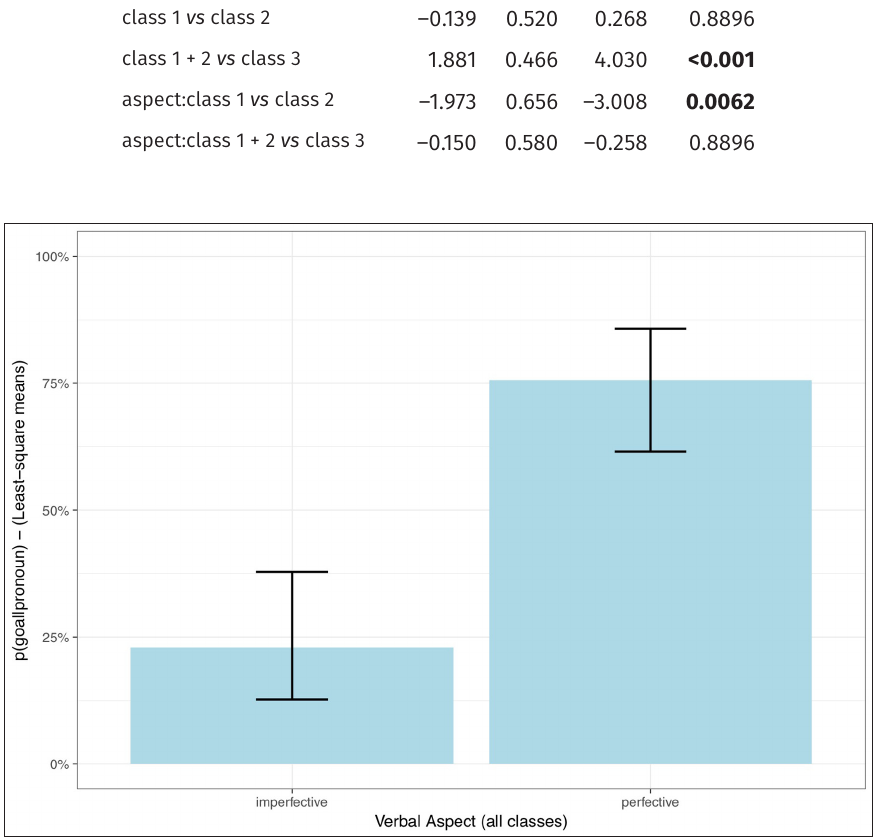
Figure 1: Effects of verbal aspect on pronoun interpretation; bars show 95% confidence interval.